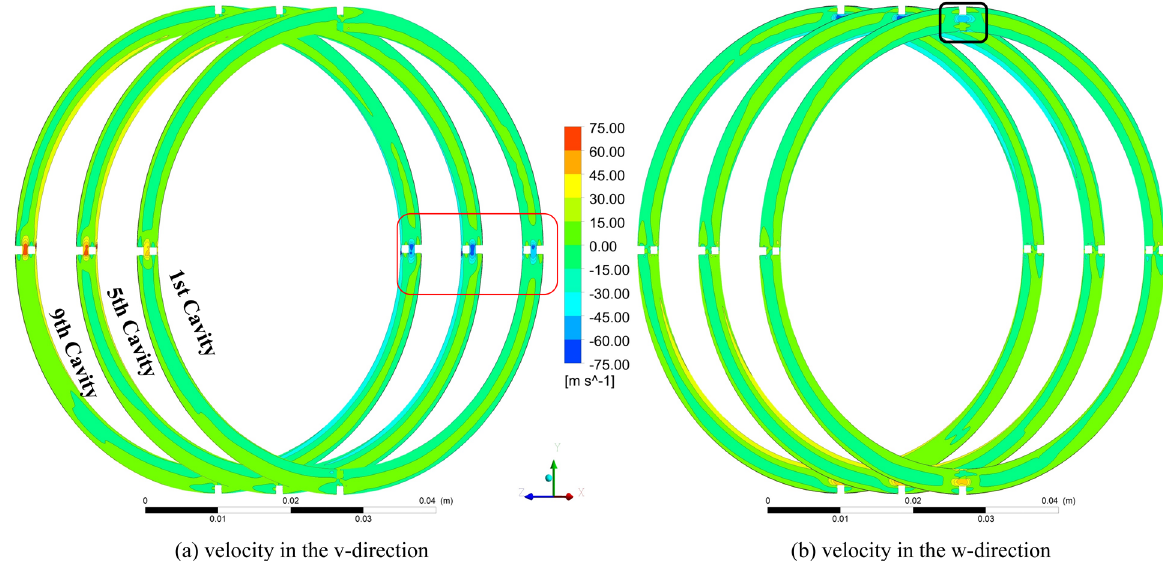
Figure 13. Circumferential direction velocity isopleth diagram in the first, fifth, and ninth cavities ( ω = 5000 rpm, Ω = 300 Hz).